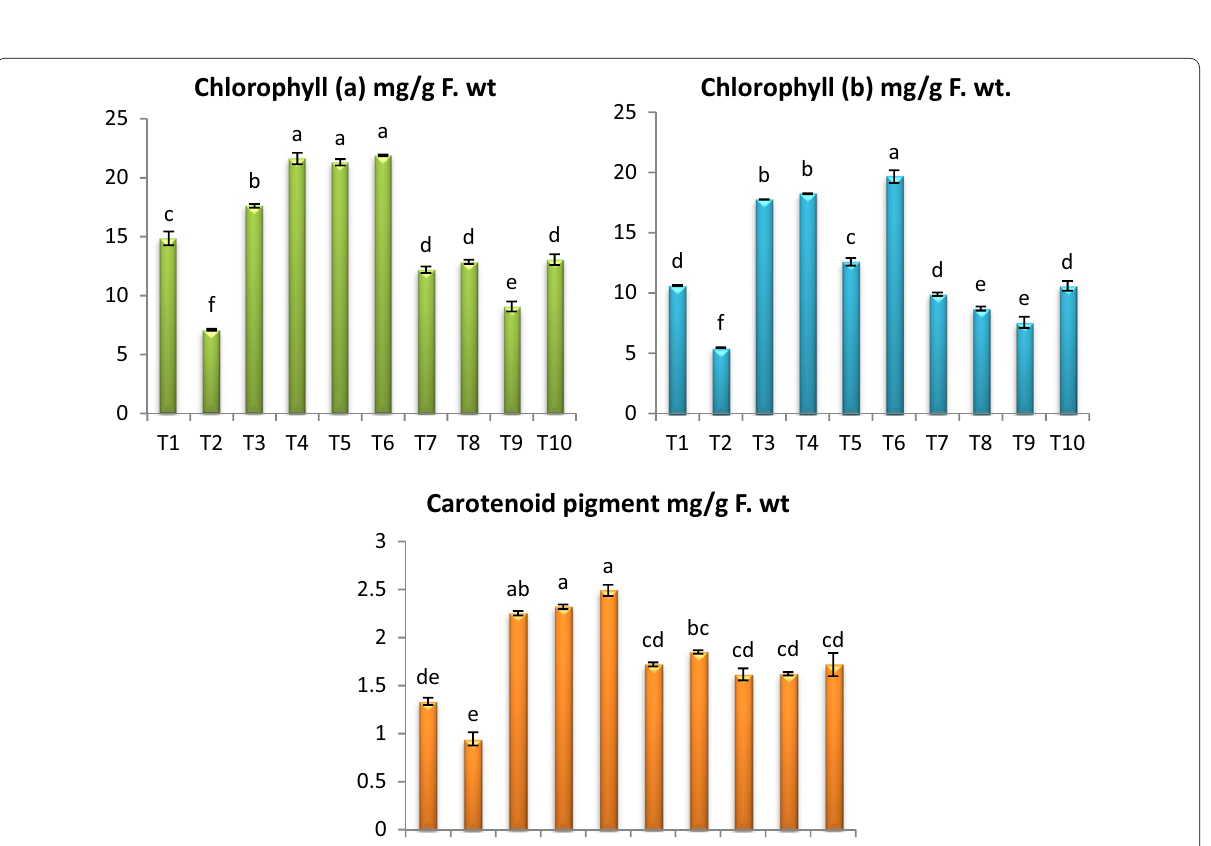
Fig. 3 Effect of F. oxysporum and endophytic isolates ( A. flavus, A. nidulans and A. fumigatus ) individual or combination on photosynthetic pigments of tomato plants. Data presented as means SD (n 3). Data followed by different letters (a:f) are significantly different LSD test at P ± = fresh weight. ( T1-Healthy control; T2-Infected control; T3-Healthy treated with A. flavus ; T4-Healthy treated with A. nidulance ; T5-Healthy treated with A. fumigatus ; T6-Healthy treated with combination of A. flavus, A. nidulance and A. fumigatus ; T7-Infected treated with A. flavus ; T8-Infected treated with A. nidulance ; T9-Infected treated with A. fumigatus and T10-Infected treated with combination of A. flavus, A. nidulance and A.